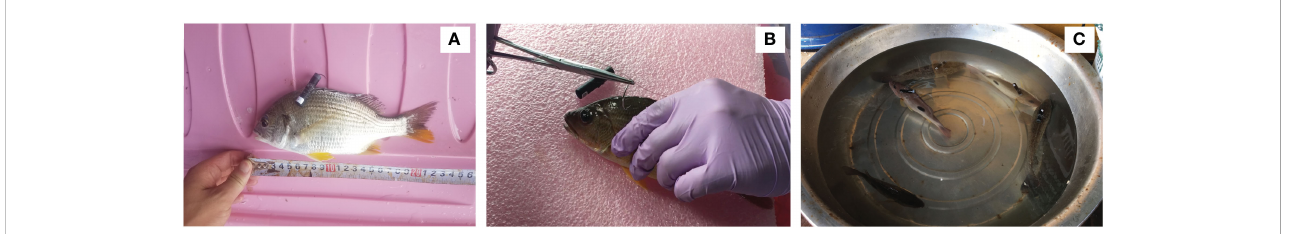
FIGURE 3 Digital images of fi sh tagging process: (A) Acanthopagrus latus tagged with a Vemco V9 acoustic transmitter, (B) a curved needle used for tagging, and (C) some tagged fi sh placed in the fresh